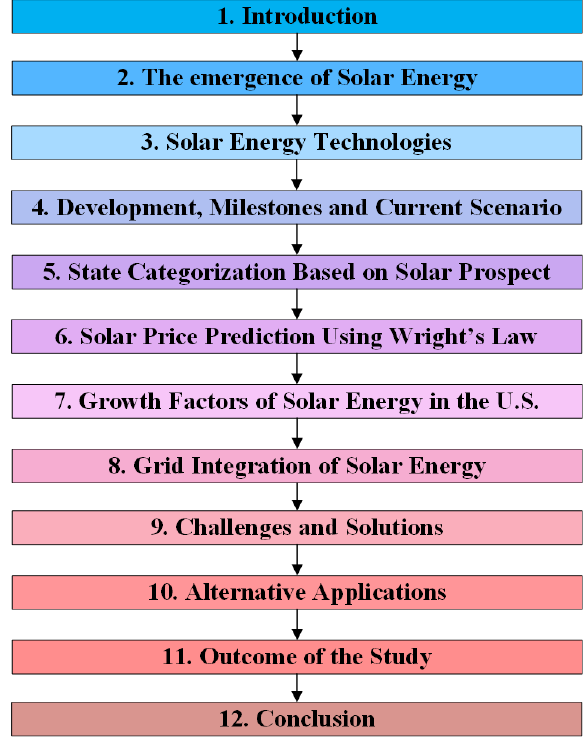
Figure 3. Information flow of this